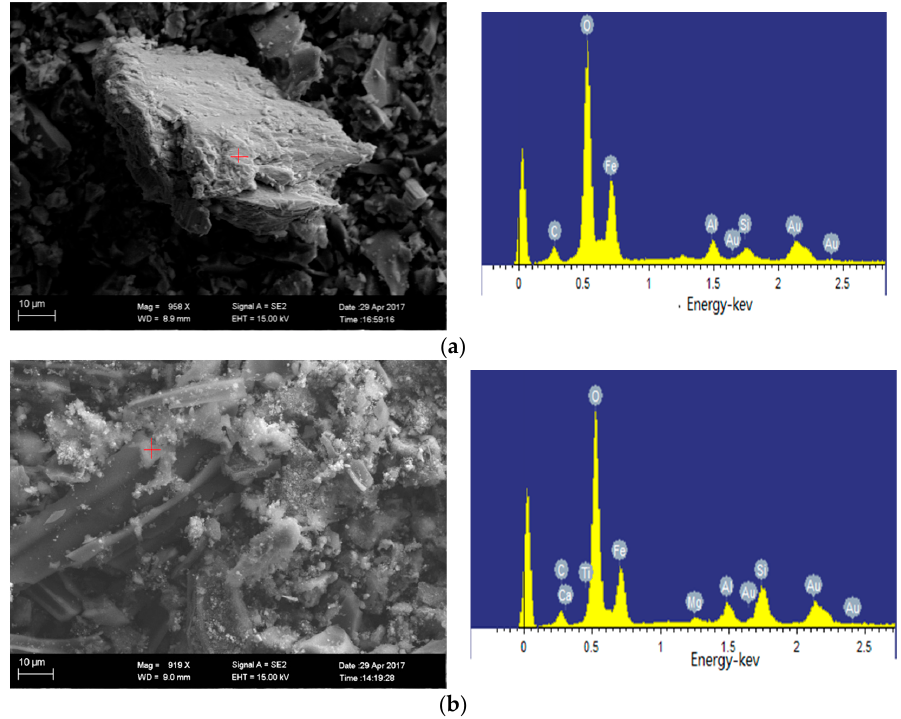
Figure 8. Minerals in reduction ash of Ulankarma lignite (SEM-EDS, secondary electron images).